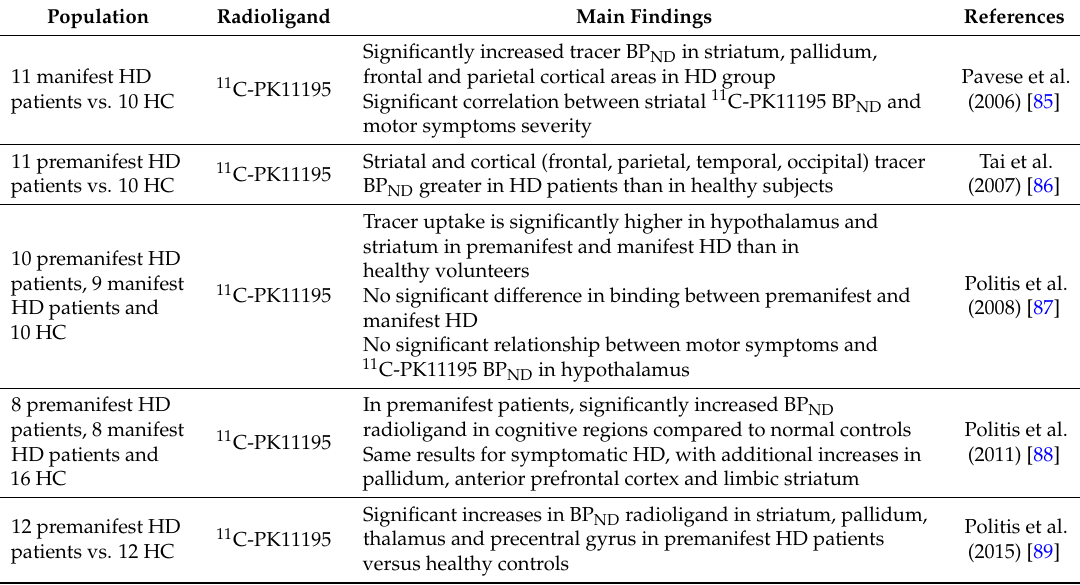
Table 3. PET imaging studies assessing TSPO tracers in Huntington’s